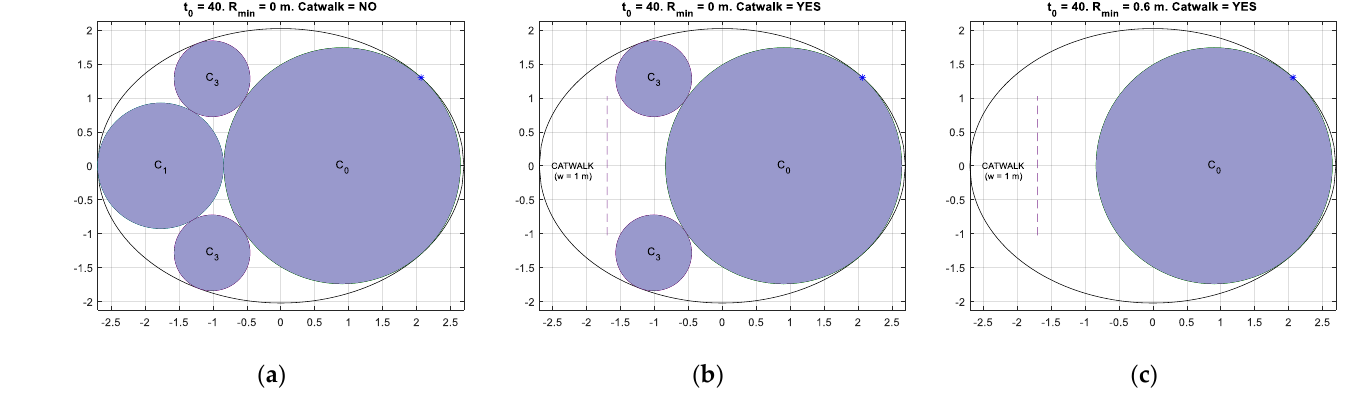
Figure 12. Examples of full-section layout for 𝑡 0 = 40°: ( a ) without catwalk ( 𝑒 𝑎 = 83%; 𝑒 𝑝 = 31%), ( b ) with catwalk ( 𝑒 𝑎 = 67%; 𝑒 𝑝 = 45%), ( c ) with catwalk and minimum radius constraint ( 𝑒 𝑎 = 56%; 𝑒 𝑝 = 100%).